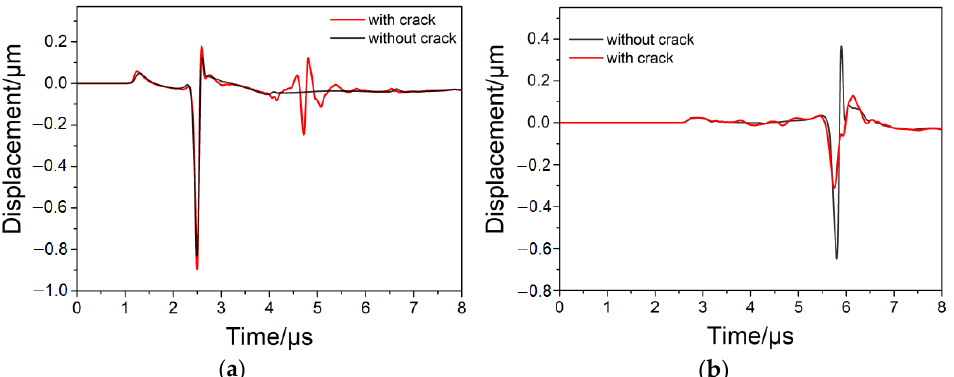
Figure 5. Laser ultrasonic direct wave and transmitted wave displacement waveform. ( a ) Reflected wave. ( b ) Transmitted wave.